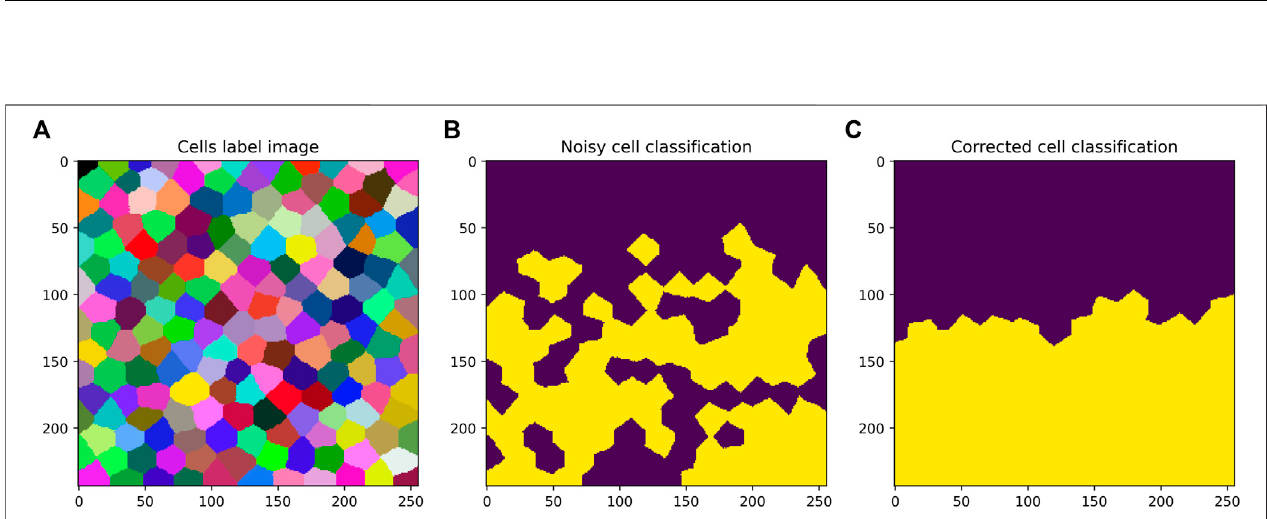
FIGURE 3 | Application of the mode fi lter to a binary parametric image. Starting from a cell grid shown as label image (A) and a corresponding imperfect classi fi cation shown as binary parametric image (B) , the application of mode fi lter of proximal cells within a radius of 80 pixels (C) can be used to locally correct classi fi cation results. Note that the cells are no hexagons. The simulated tissue consists of cells with variable shape, position and size.